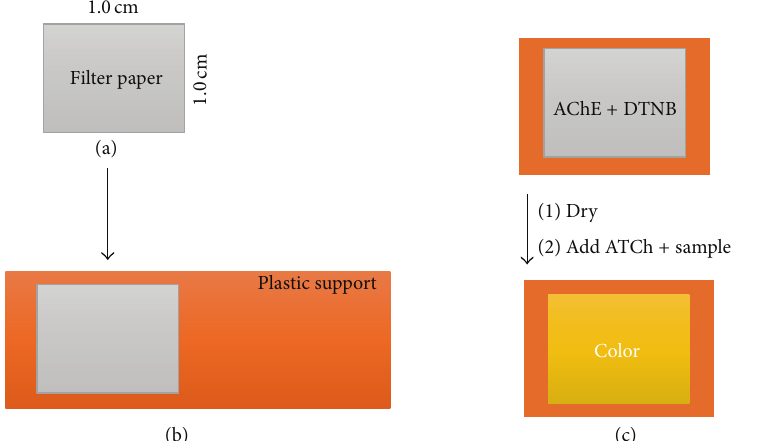
Figure 1: Schematic representation of biosensor support construction. (a) Munktell filter papers were cut and (b) fixed on a plastic support. (c) The enzyme mixture (AChE and DTNB) was directly applied on the fixed paper and dried. The samples with ATCh were directly applied on dried paper strips for color